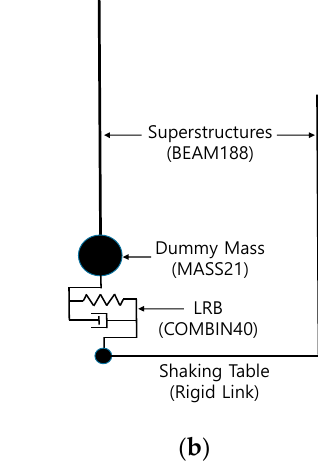
Figure 18. Seismic analysis model: ( a ) Schematics of the test mockup; ( b ) Finite element model.